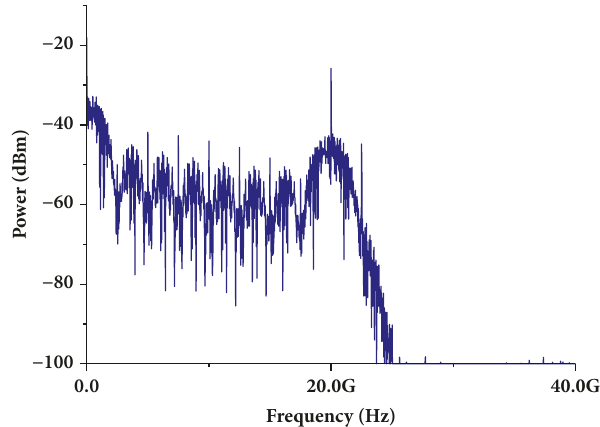
Figure 7: Optical spectrum of 40GHz mm-wave.